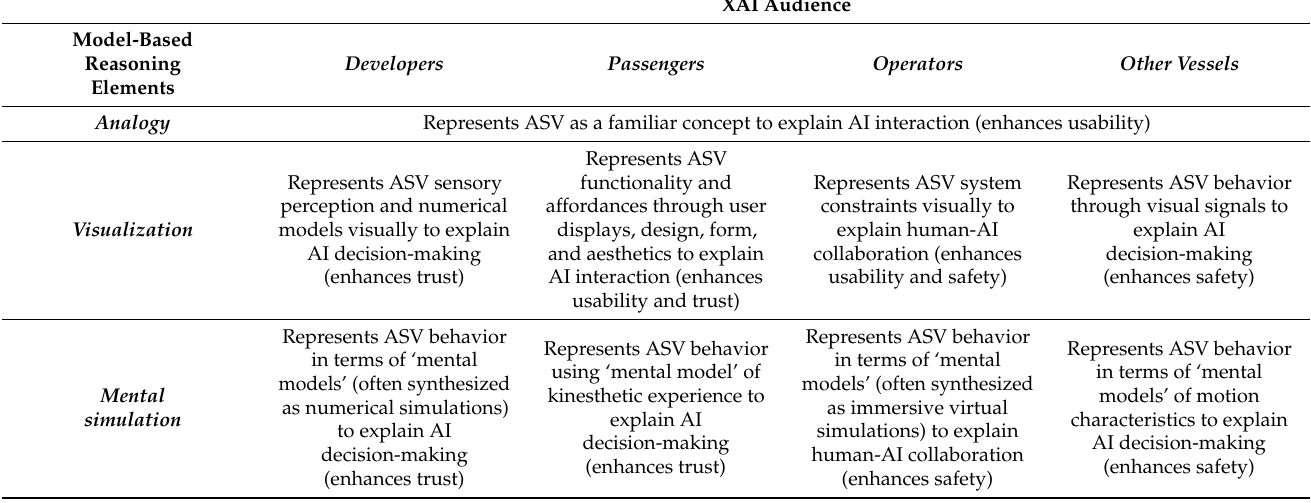
Table 1. Summary of human-centered XAI processes present in the examples presented.